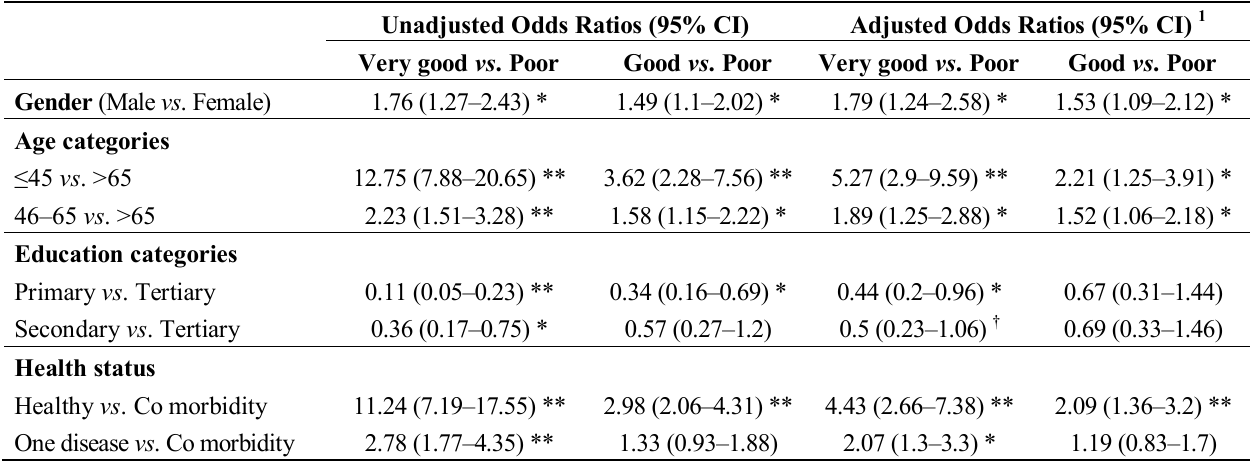
Table 2. Multinomial regression analyses of sociodemographic and disease-related variables with SRH as dependent variable (N = 1,519).